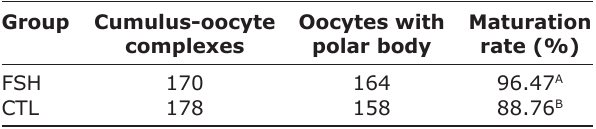
Table-1: Nuclear maturation rates after exposure of bovine cumulus-oocyte complexes to FSH supplementation (FSH+) or its vehicle (CTL) during in vitro maturation for 22 h.